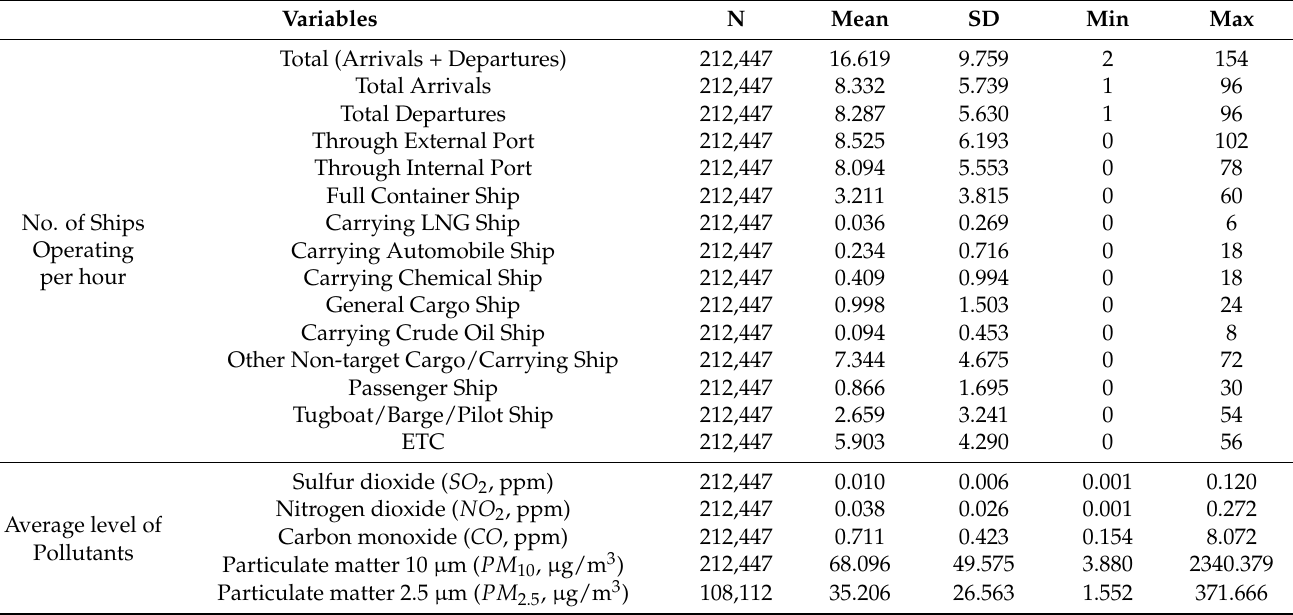
Table 2. Summary